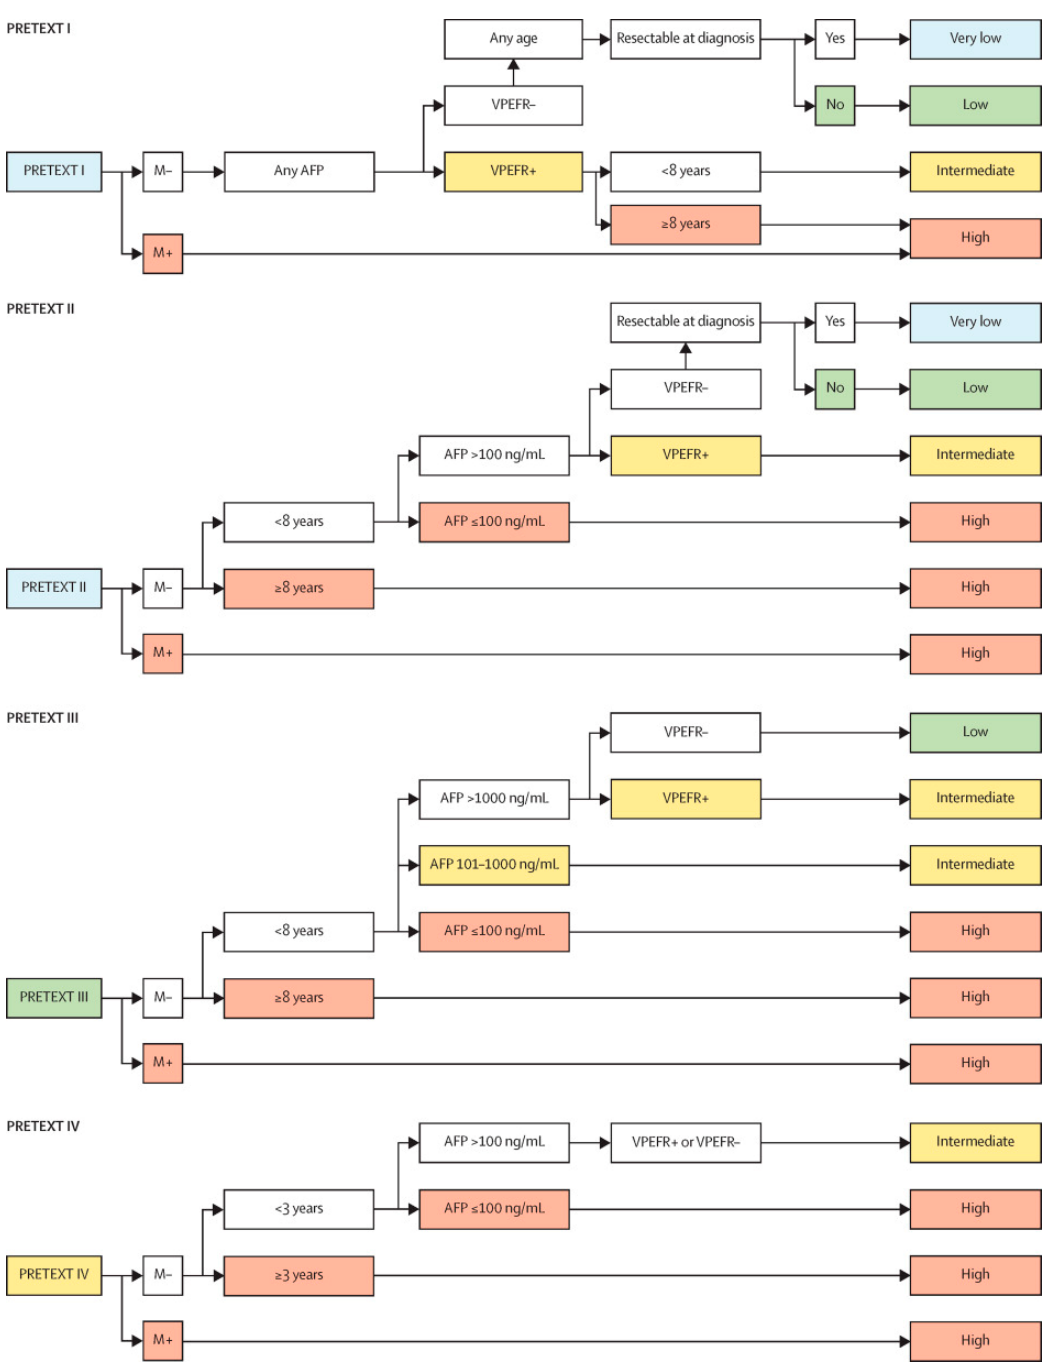
Figure 2. These stratification trees are used as the framework for management of hepatoblastoma in the AHEP-1531 study [5]. AFP = alpha-fetoprotein.